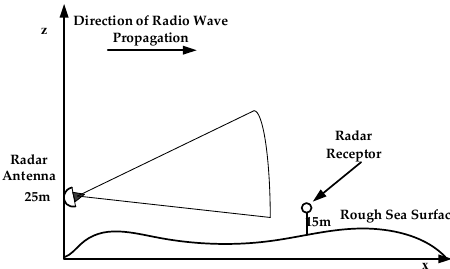
Figure 1. Conceptual model of a rough sea surface. The radar antenna is placed at a certain height in space, and the radar receptor is arranged in the X or Z direction in order to obtain the propagation loss on the location. Here we take the altitude of 0 m as the sea level. The radar antenna height is 25 m. The height of radar receptor is 15 m and the horizontal distance is 13 km. The sea surface roughness is related to the sea surface wind speed, where the wind speed is 7 m/s.